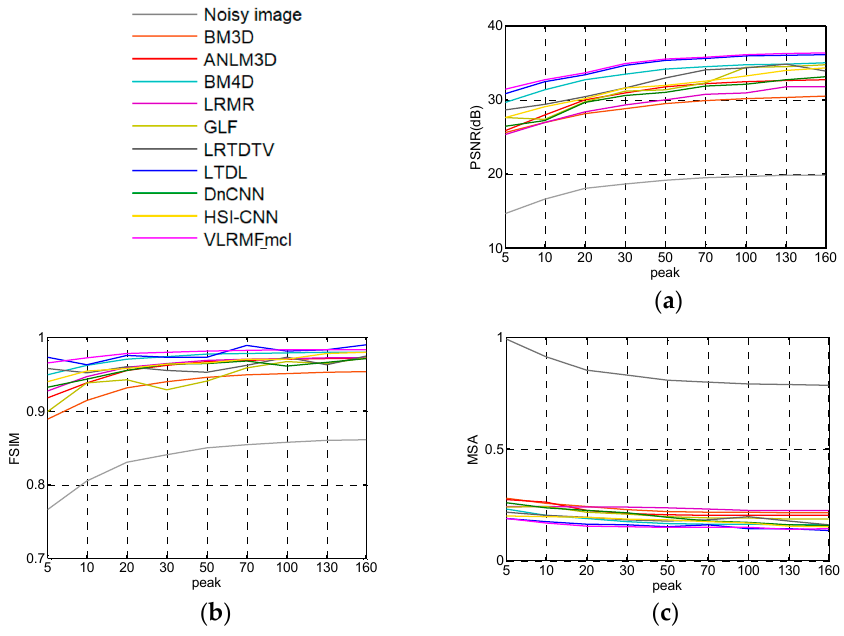
Figure 4. Quantitative evaluation results for Beads data versus different noises: ( a ) peak signal-to-noise ratio (PSNR); ( b ) feature similarity (FSIM); ( c ) mean spectral angle (MSA).